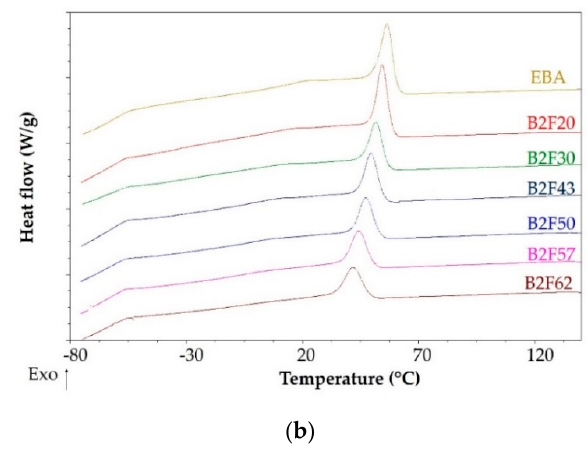
Figure 4. ( a ) Differential Scanning Calorimetry (DSC) thermograms of the EBA copolymer, ECH resin, and their binary blends. Second heating run; ( b ) DSC thermograms of the EBA copolymer, ECH resin, and their binary blends: Cooling run.